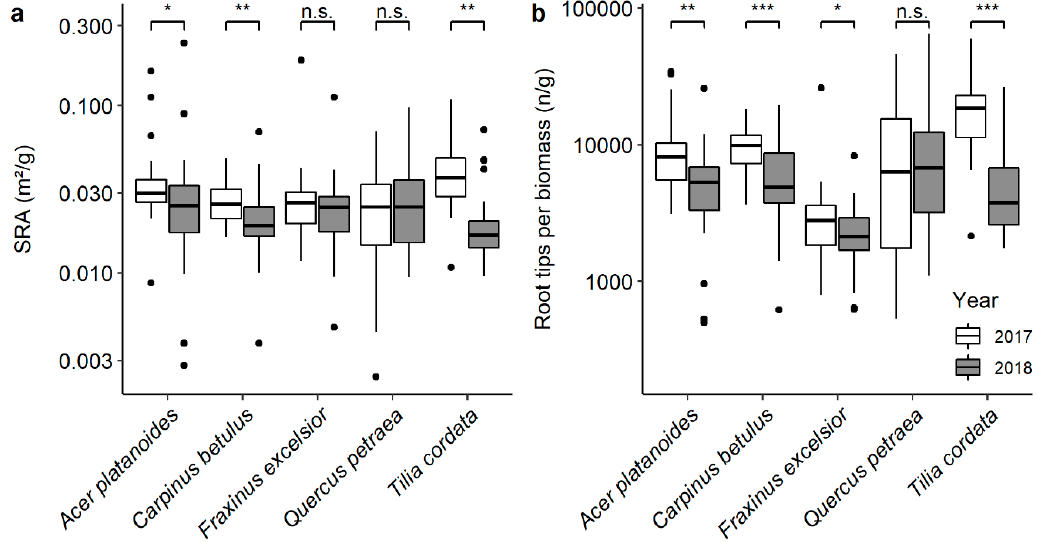
Figure 3. Specific root surface area (SRA) ( a ) and root tips per fine root biomass ( b ) of the five tree species in the topsoil (0–10 cm) in April 2017 and September 2018. Box-whisker plots for all species and both inventories with median and interquartile ranges (Q 1 –Q 3 ); whiskers extend to 1.5 times the interquartile range. Indicated significant differences between the inventories for each species are based on a non-parametric signed-rank-test; ***: p ≤ 0.001, **: p ≤ 0.01, *: p < 0.05. Note the log-scaled y-axes.